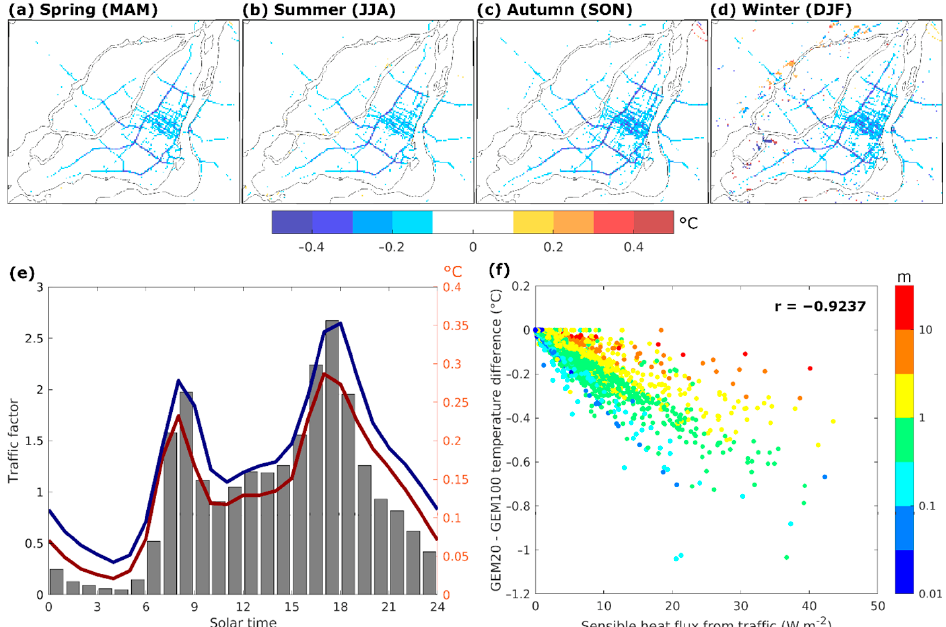
Figure 6. Average 2 m temperature difference at 5 p.m. local time (traffic peak) between the GEM20 and the GEM100 simulations for ( a ) spring, ( b ) summer, ( c ) autumn, and ( d ) winter. ( e ) Daily cycle of 2 m temperature differences between those simulations, during winter (DJF; blue) and summer (JJA; red), averaged for grid cells with sensible heat flux from traffic exceeding 10 W m − 2 . Gray bars show the multiplicative factor for heat flux from traffic for each hour of the day. ( f ) Median 2 m temperature difference at 5 p.m. local time for each grid cell as function of the sensible heat flux from traffic. Colours show the average roughness length of the urban fraction.